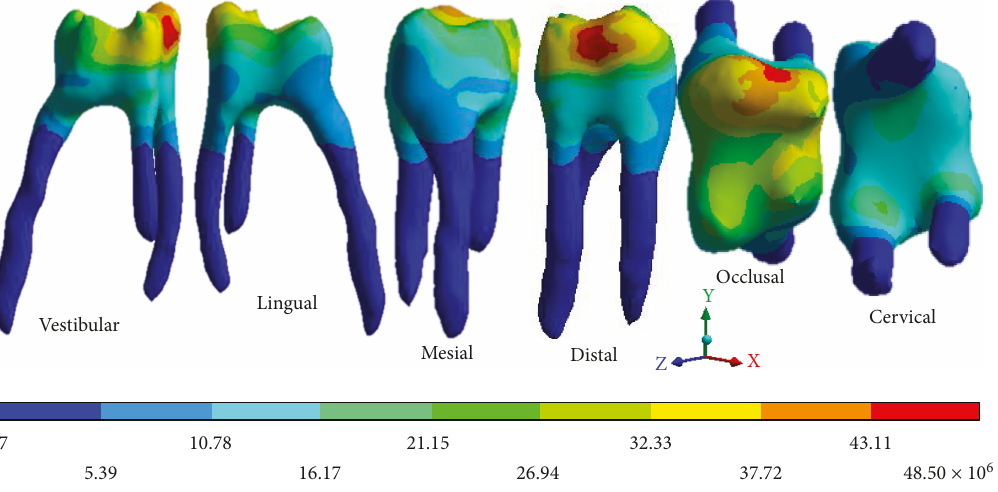
Figure 11: 1st degree caries : von Mises stresses in